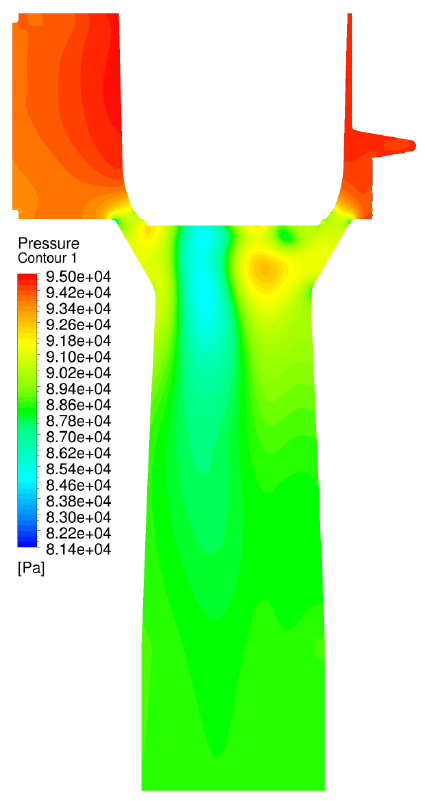
Fig. 8. Pressure flow field in the compact valve with the original chamber